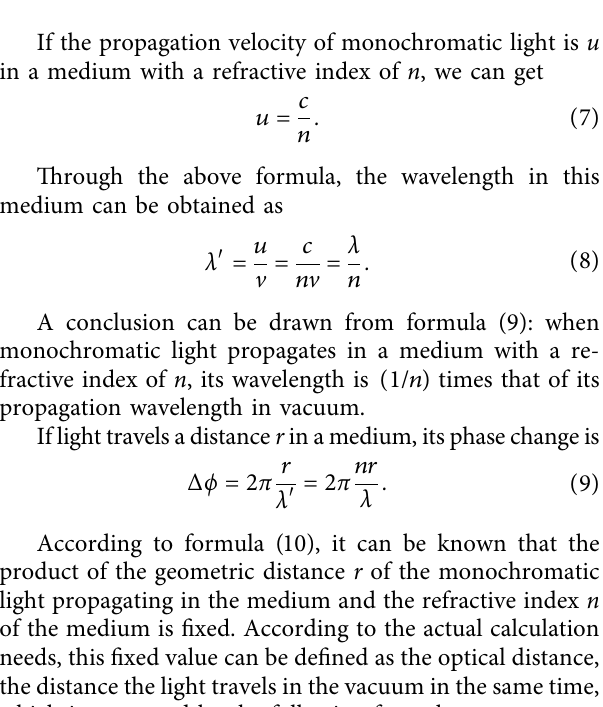
Figure 5: Relationship between diffraction line orientation and crystal